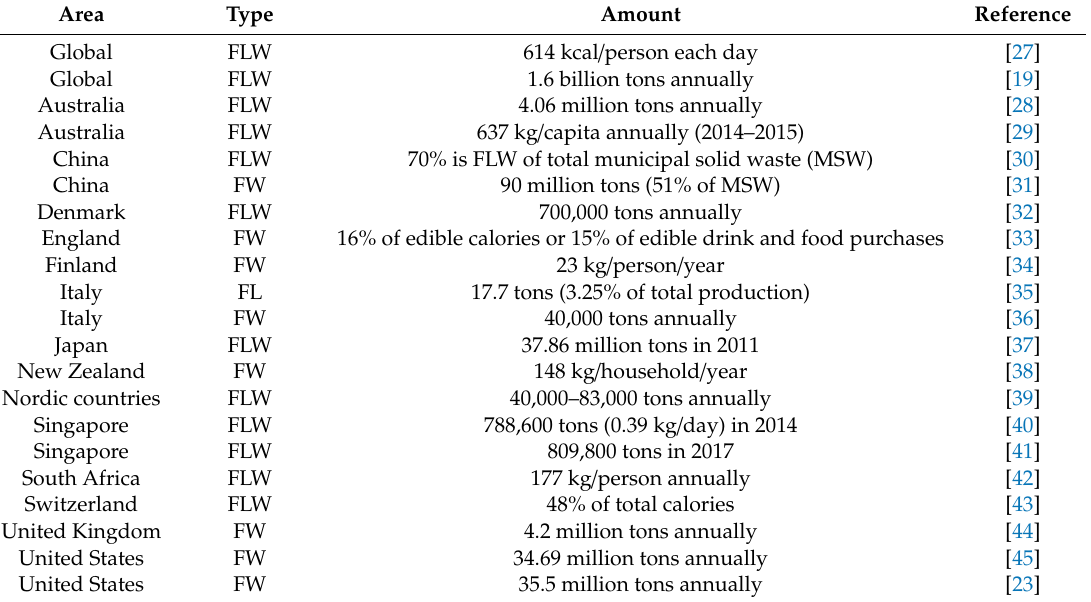
Table 3. Estimated quantities of FLW by